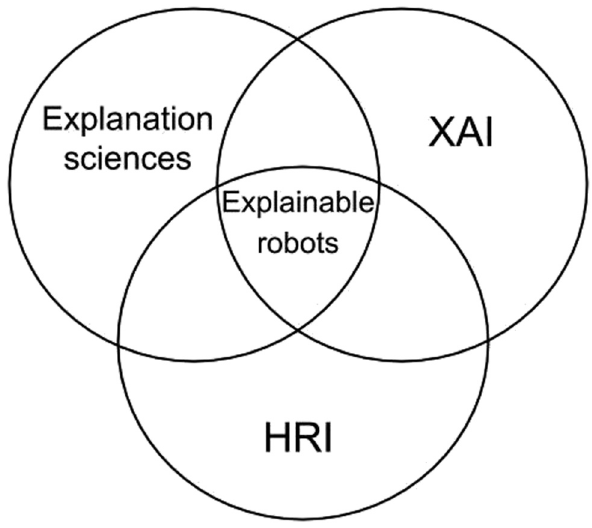
Figure 1: The interdisciplinary challenge of explainable